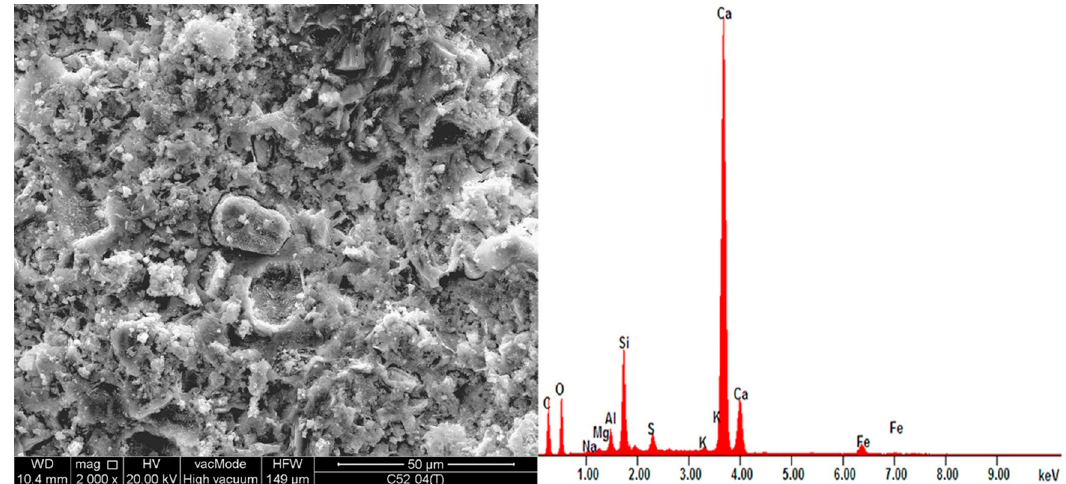
Figure 10. EDS spectra of series C52 with w / c = 0.4 together with the SEM image of the analyzed area.